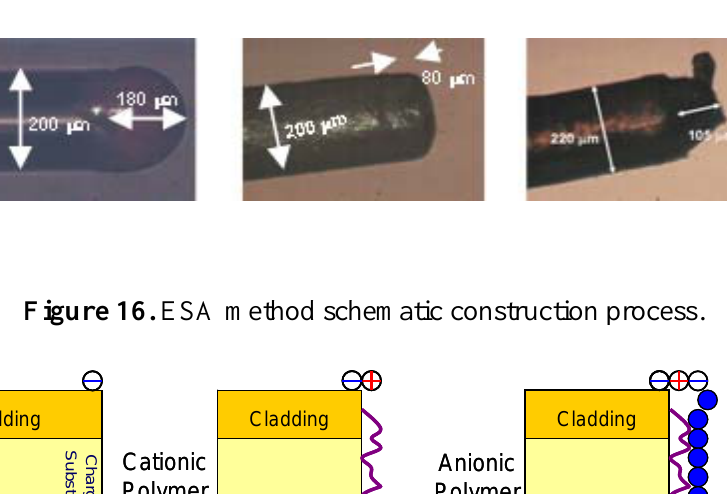
Figure 15. Optical fiber tips dip coated in sol-gel. The deposition is uniform through the cladding but irregular on the cut-ended extreme.